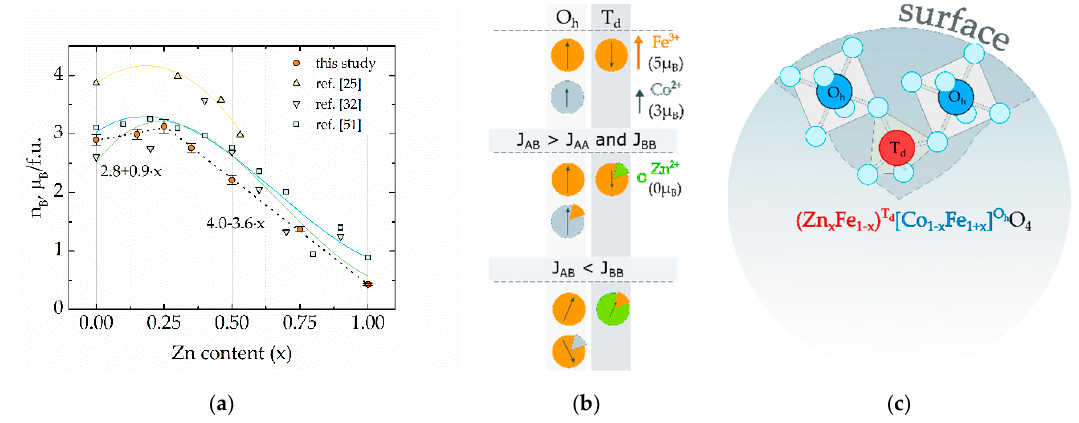
Figure 3. ( a ) Dependence of net magnetic moment per formula unit for cobalt ferrite nanoparticles doped with zinc from this research compared with reference systems [25,32,51]; ( b ) diagram of the evolution of the magnetic structure of cobalt ferrite when is doped with zinc; ( c ) illustration of spinel structure of co-doped Zn-Co ferrite: in nanoferrites the octahedral (O h ) positions of spinel preferably allocated on the surface rather than tetrahedral (T d ) positions.